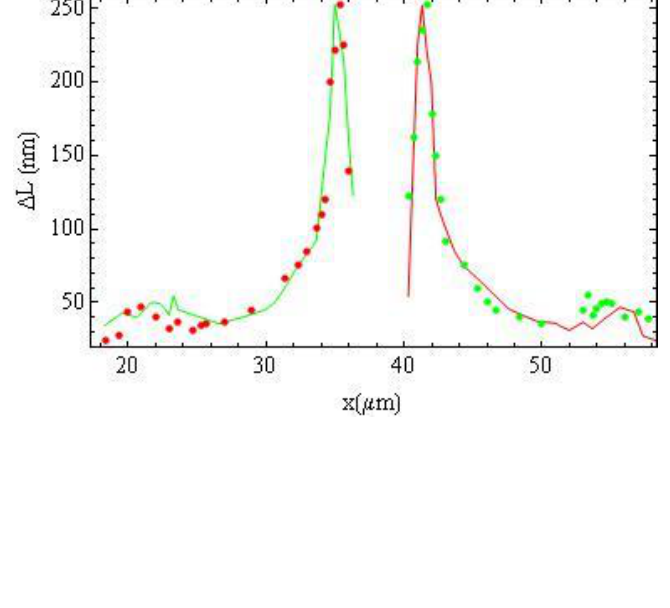
Figure 17. Fitting the left wing (red) of Figure 14 (a) with interpolation from the right wing (green) and vice versa allows us to determine the center of